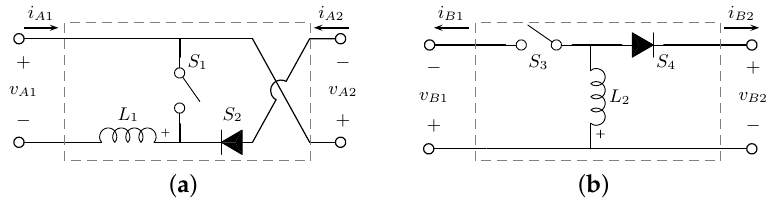
Figure 2. Nonisolated basic switching cells: ( a ) boost; ( b ) buck-boost.